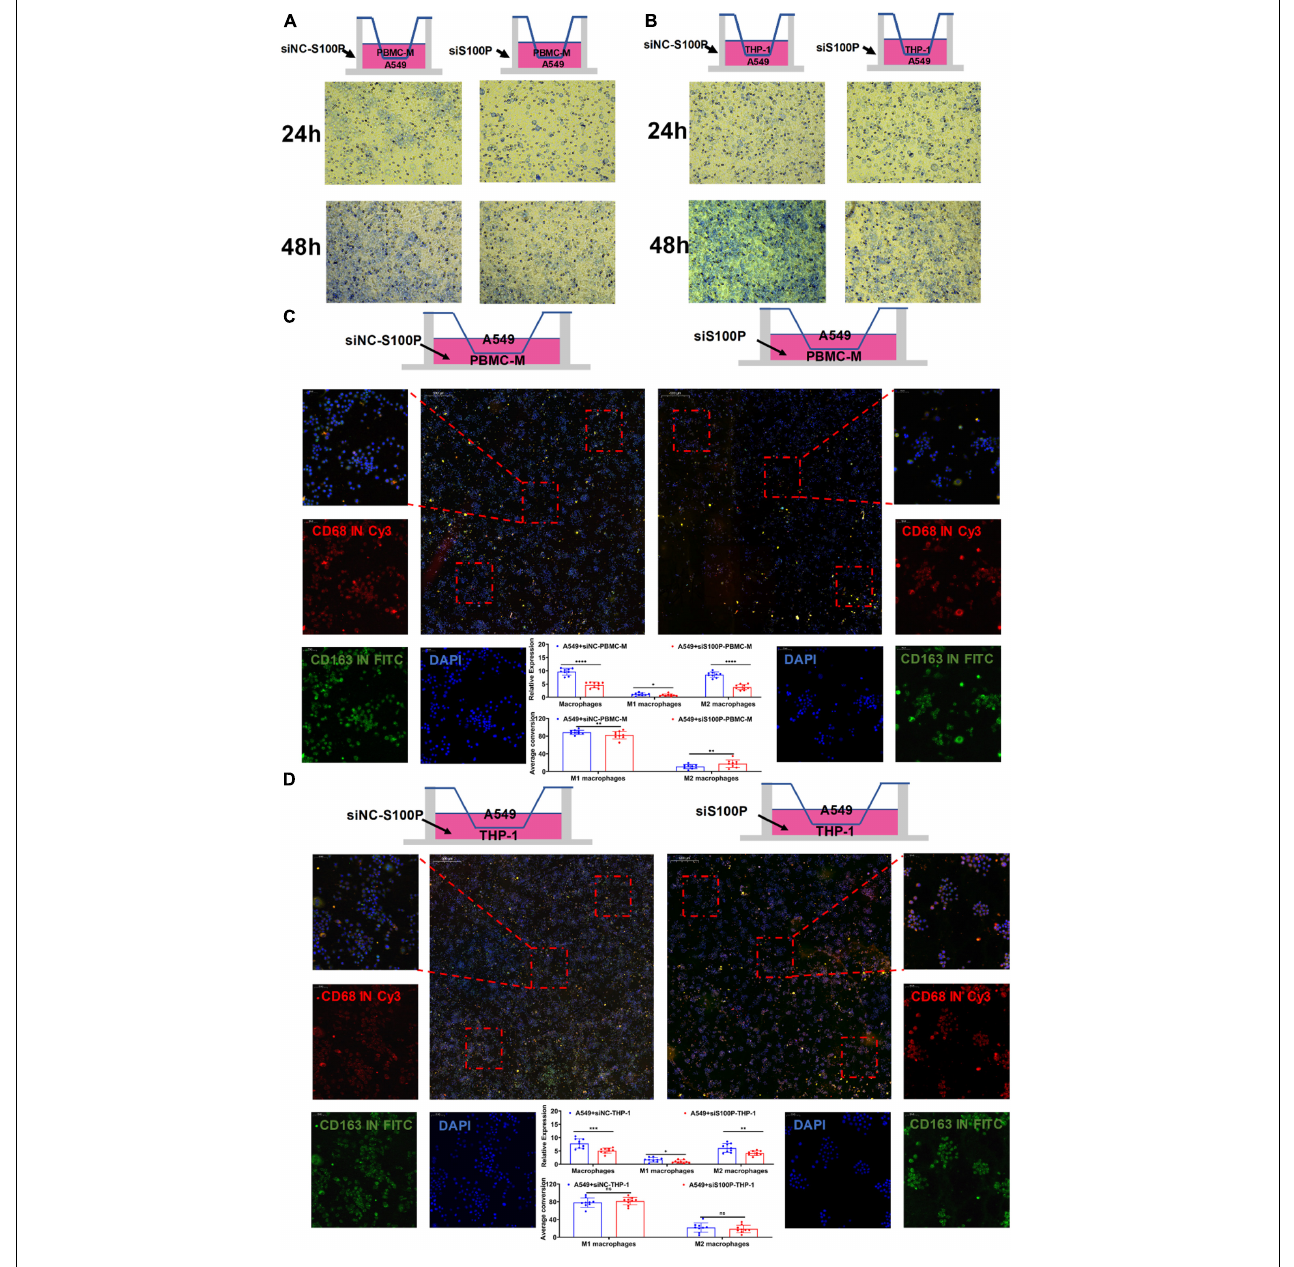
FIGURE 10 | Primary macrophage culture and siRNA transfection. (A) Co-culture of PBMC-M after treatment of A549 cells with siNC-S100P and siRNA-S100P. (B) Co-culture of THP-1 after treatment of A549 cells with siNC-S100P and siRNA-S100P. (C) Effect of A549 cells knocking down S100P on the transformation of PBMC-M cells. (D) Effect of A549 cells knocking down S100P on the transformation of THP-1 cells. * p < 0.05, ** p < 0.01, *** p < 0.001, **** p <